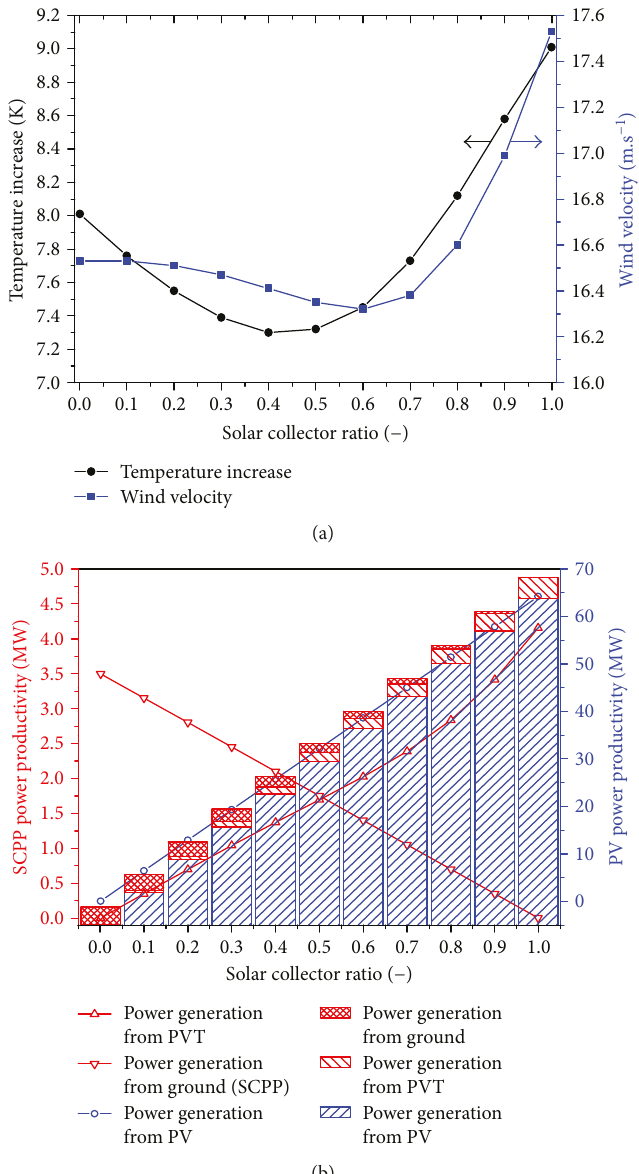
Figure 7: (a) Temperature increase and wind velocity in the SCPVTPP under di ff erent solar collector ratios. (b) Power generation from PVT, PV, and ground and the total power generation under di ff erent solar collector